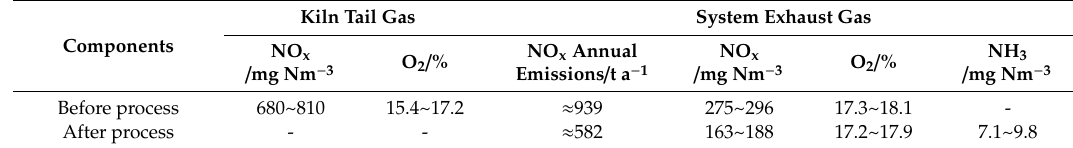
Table 4. Denitration effect of flue gas before and after advanced reburning.